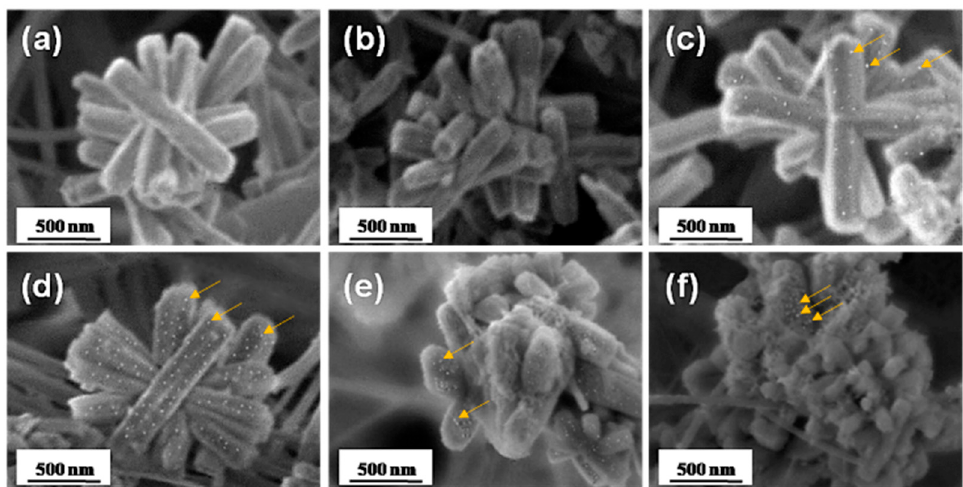
Figure A1. SEM images of a low ‐ crystalline zinc oxide substrate at different resolutions ( a ) 2 μ m, ( b ) 1 μ m, ( c ) 500 nm.